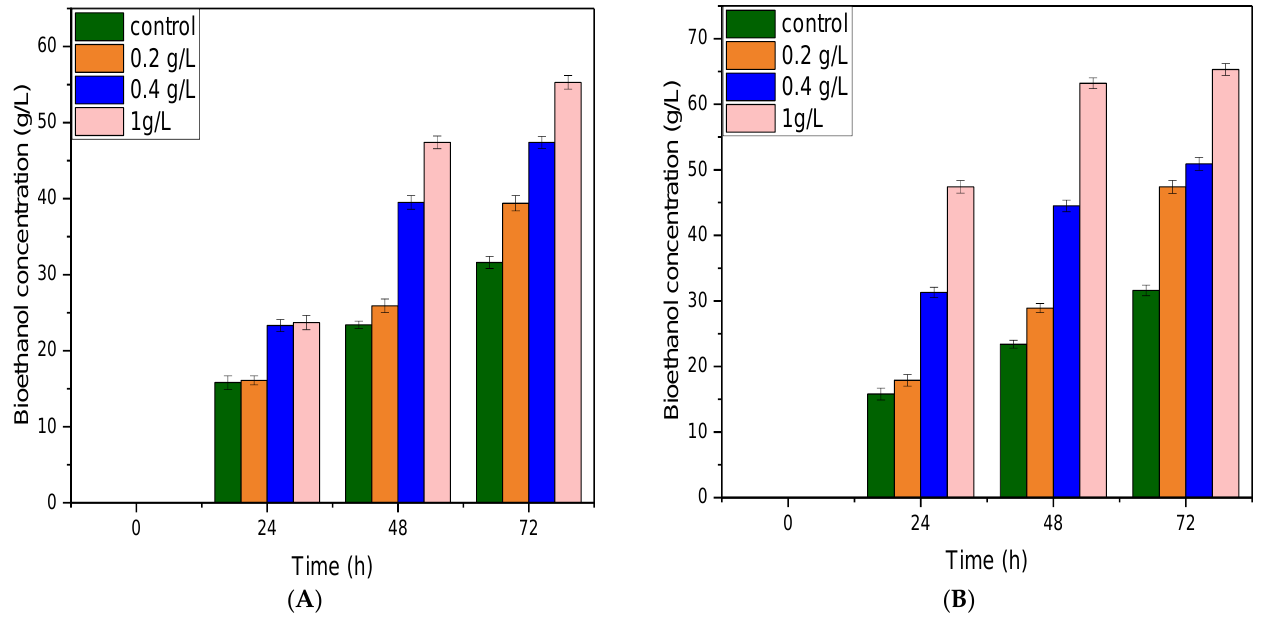
Figure 4. Bioethanol concentration during alcoholic fermentation: ( A ) effect of yeast extract and ( B ) effect of NH 4 Cl.